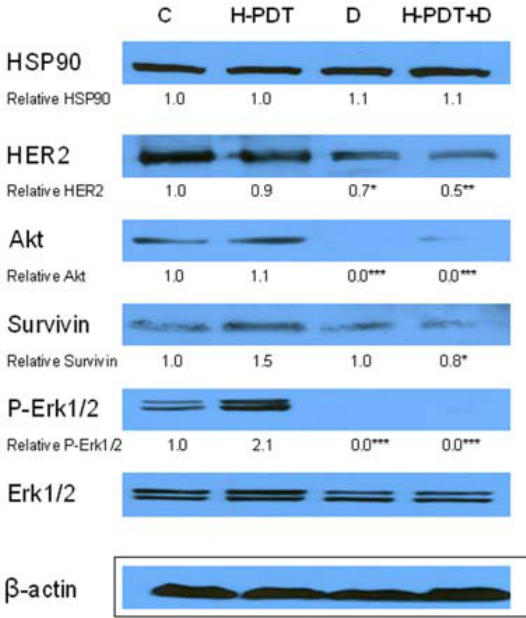
Data are presented as representative picture of three Western blots and as means of densities taken from three independent experiments. The statistical significance is designated as follows: